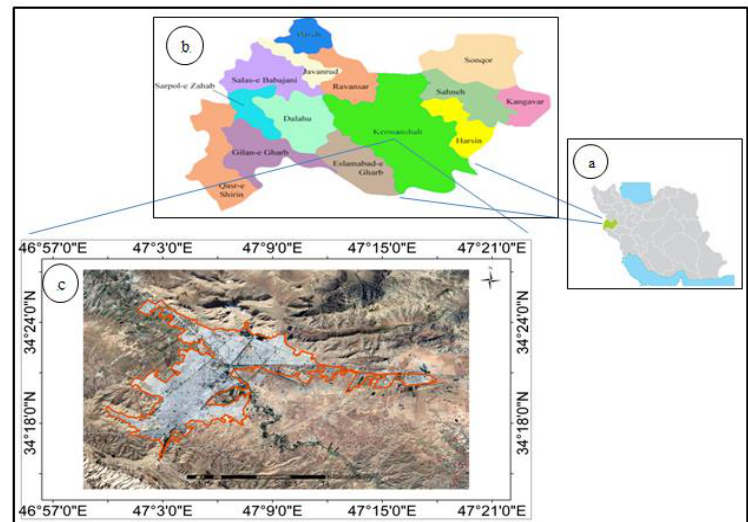
Figure 1. Location of study area: (a) in Iran, (b) in the Kermanshah province, and (c) in the Kermanshah city (background: Google Earth